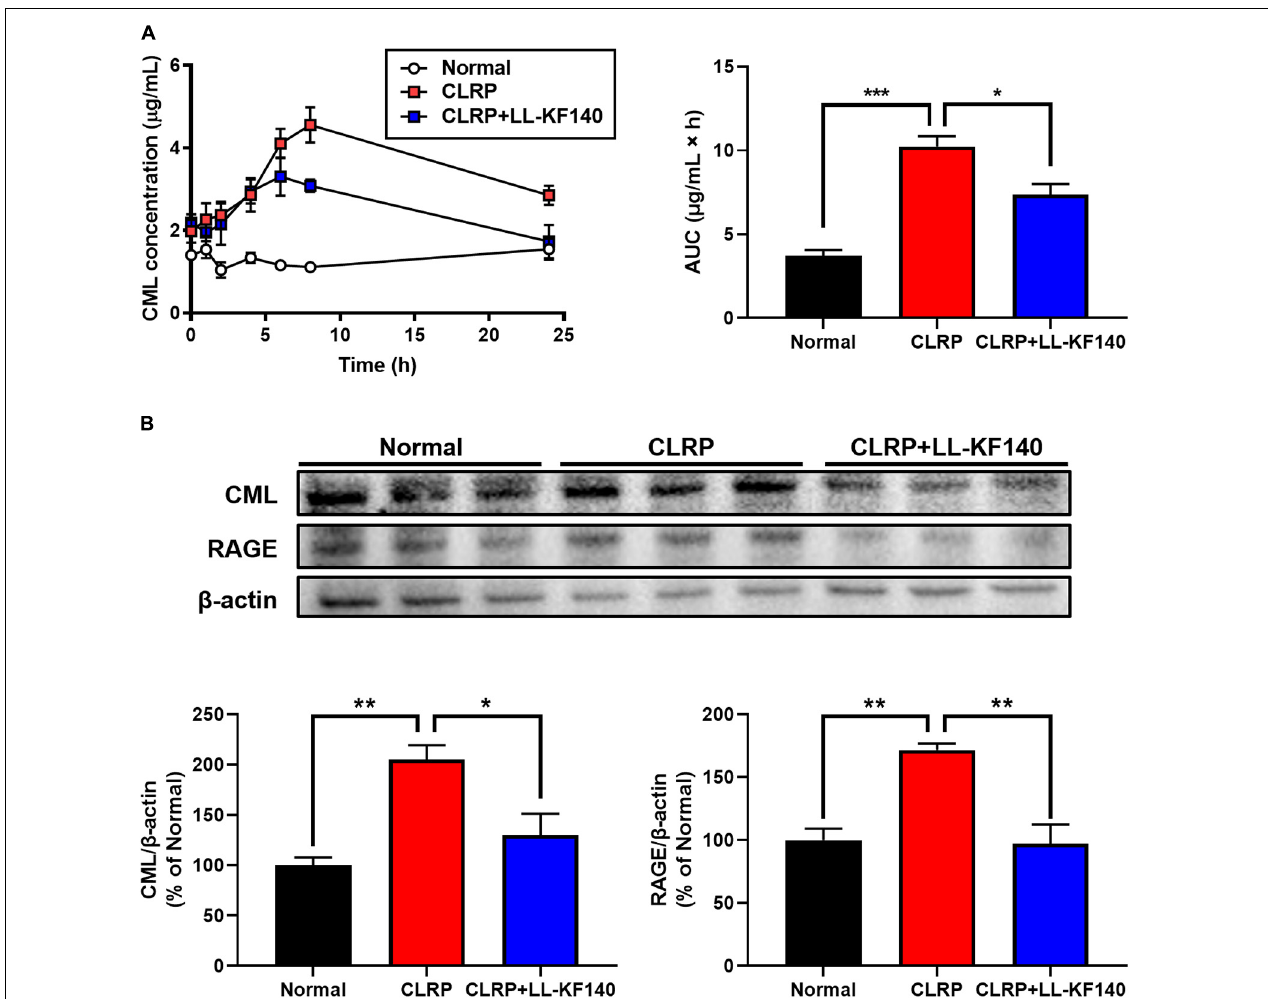
FIGURE 2 | Effect of oral administration of Lactococcus lactis KF140 (LL-KF140) on N ε -(Carboxymethyl)lysine (CML) levels in the serum and liver tissues of rats after 10 mg/kg CML administration in a casein-lactose reaction product (CLRP). (A) Serum CML levels in rats with and without LL-KF140 administration. (B) Levels of CML and the receptor for advanced glycation end products (RAGE) in rat liver tissues. Data are presented as the mean ± SEM ( n = 3). * p < 0.05, ** p < 0.01, *** p < 0.001 (one-way ANOVA, followed by Tukey’s